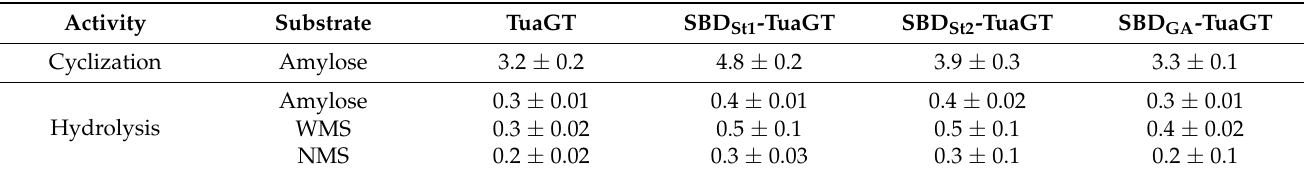
Table 3. Hydrolysis and cyclization by Tu α GT and SBD-Tu α GT fusions acting on amylose and gelatinised maize starches at 70 ◦ C and pH 7.0.